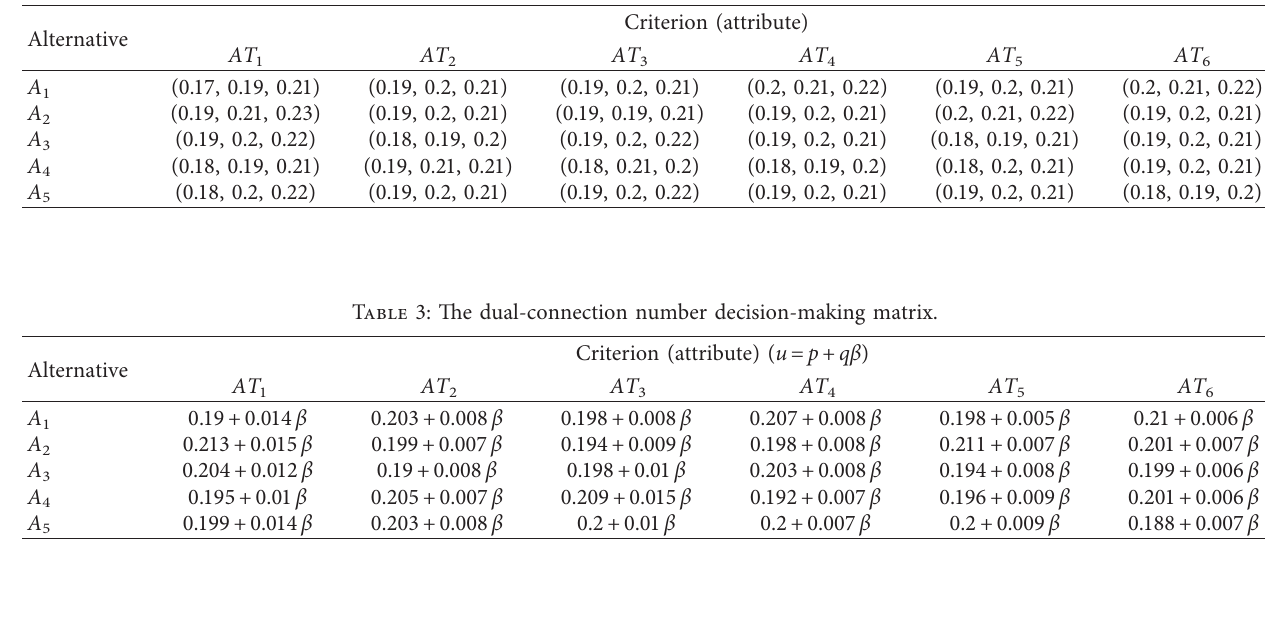
Table 2: The normalized decision-making matrix.